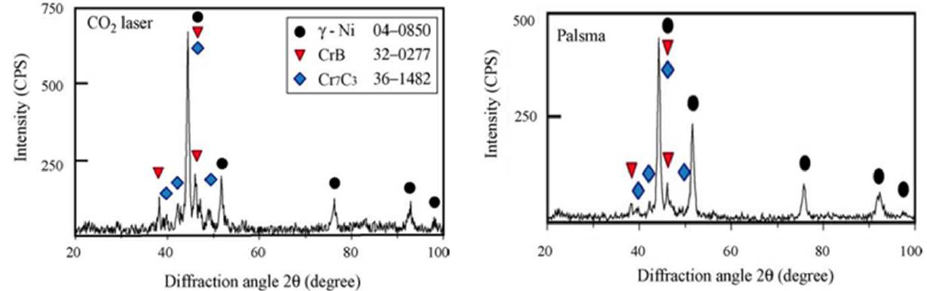
Figure 22. Results of X-ray diffraction analysis of WELPC-6 laser-cladded layers [112].